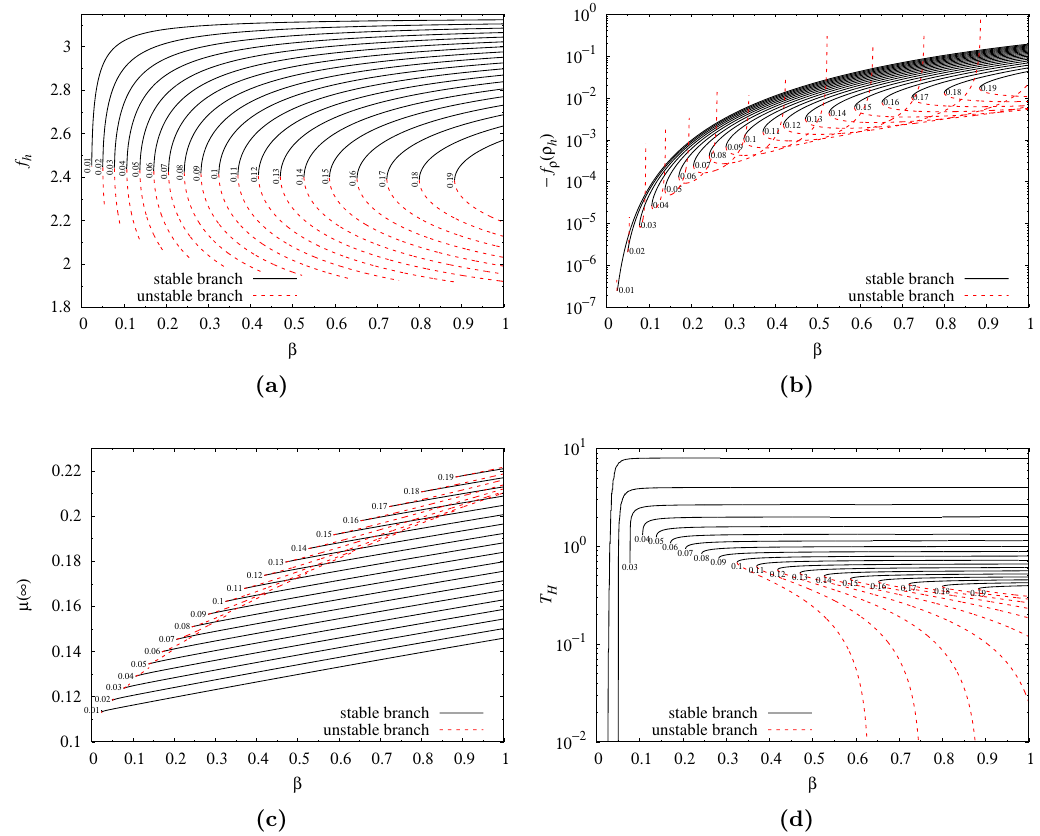
Figure 4 . Stable (black solid lines) and unstable (red dashed lines) branches of solutions in the 2 + 4 + 8 model with (cid:13) = 0: (a) the value of the pro(cid:12)le function at the horizon, f h ; (b) the derivative of the pro(cid:12)le function at the horizon, f (cid:26) ( (cid:26) h ); (c) the ADM mass, (cid:22) ( 1 ); (d) the Hawking temperature T H , all as functions of the Skyrme-term coe(cid:14)cient, (cid:12) . The numbers on the (cid:12)gures indicate the di(cid:11)erent values of (cid:26) h = 0 : 01 ; 0 : 02 ; : : : ; 0 : 19.